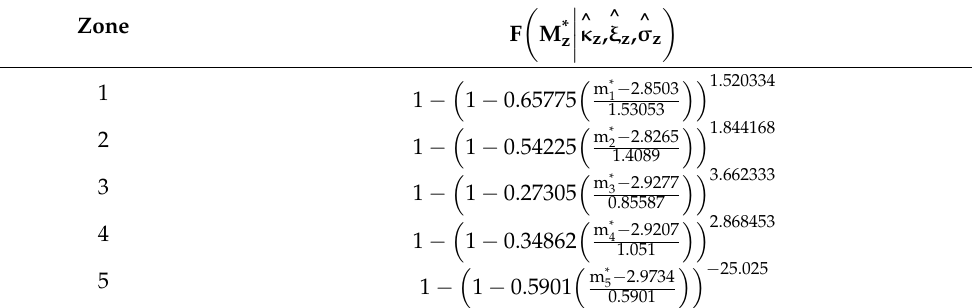
Table 10. The CDF of GPD in Cluster Type II. Zone